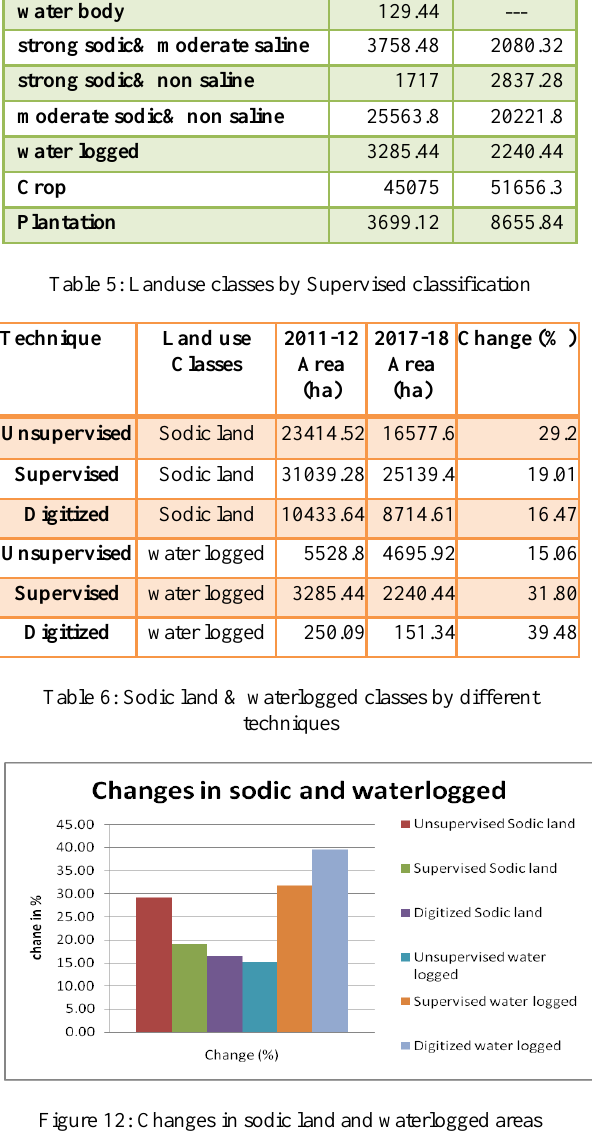
Figure 12: Changes in sodic land and waterlogged